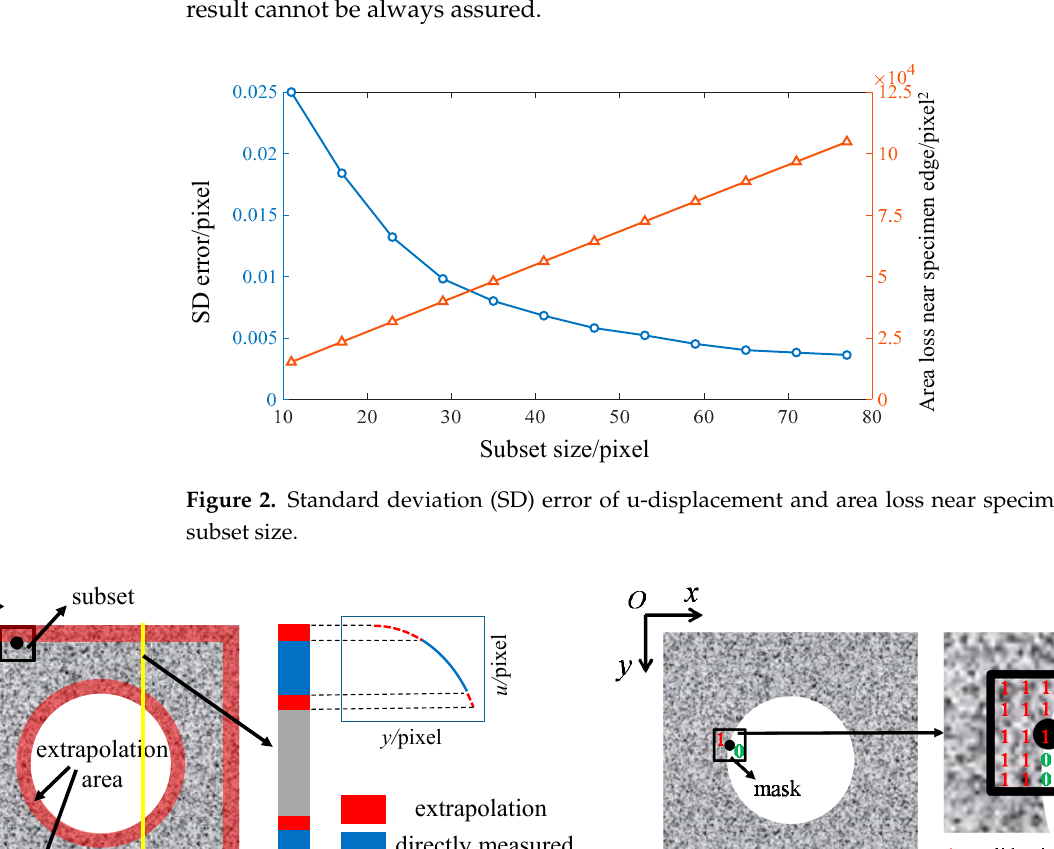
Figure 3. Conventional methods for boundary displacement calculation: ( a ) Extrapolation method and ( b ) half-subset method.